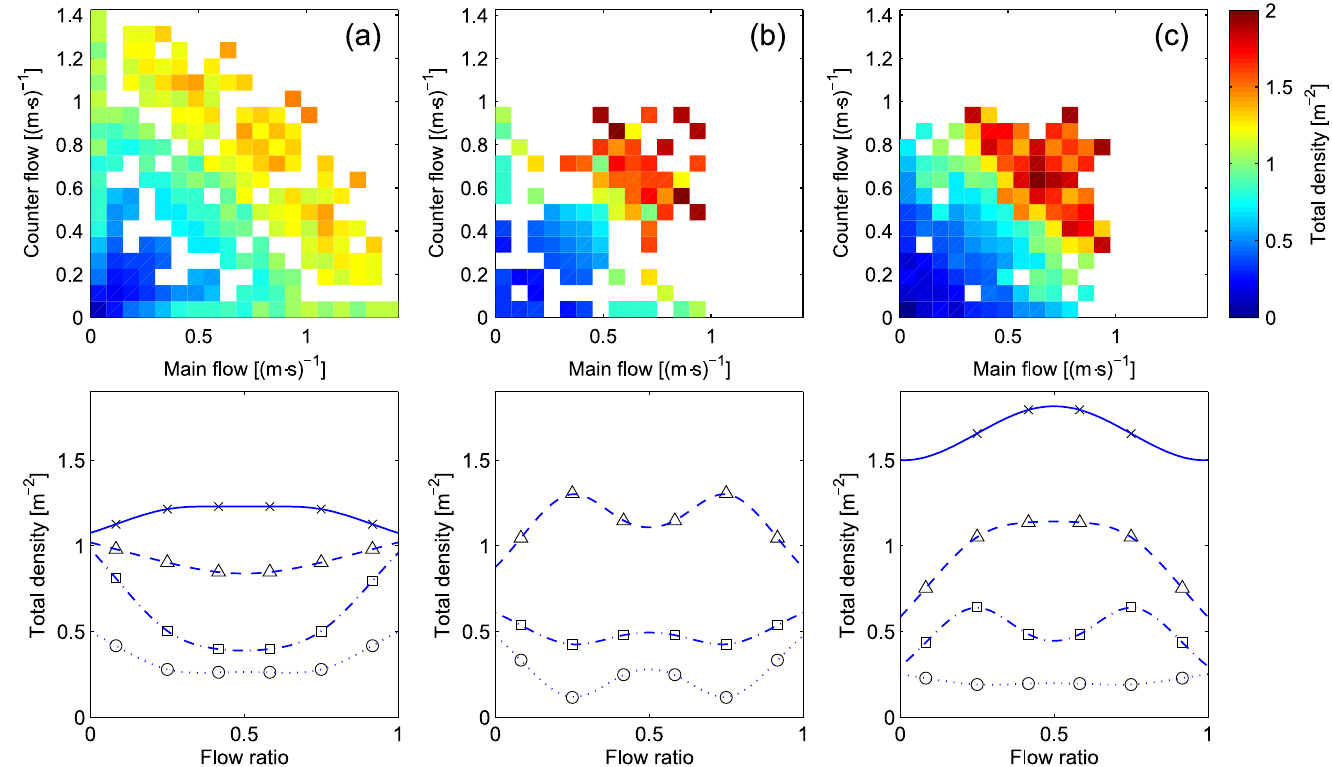
Fig 8. Density. The same color scale is used for all scatter plots. Interpretation for the flow ratio representation is provided in Table 4.